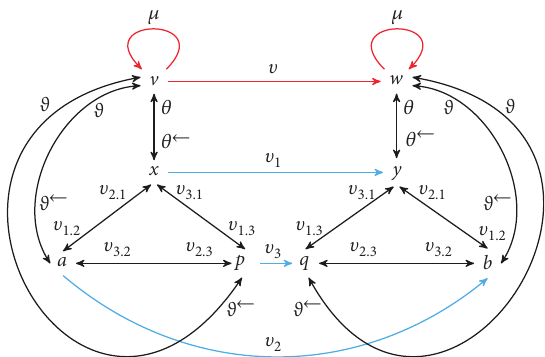
Figure 8: A diagrammatic depiction of inferred arcs (red) in topic networks, inferred by means of various arcs (black and blue) of an underlying LMN. Orientation of inferred arcs is provided by three denotes two texts, a,b ∈ V types of input arcs (blue). x, y ∈ V 1 2 denotes two authors working on x , and y , respectively, p, q ∈ V 3 denotes two lexical units occurring in x and y , respectively. Inferred weights of vertices are denoted by means of (red) reflexive